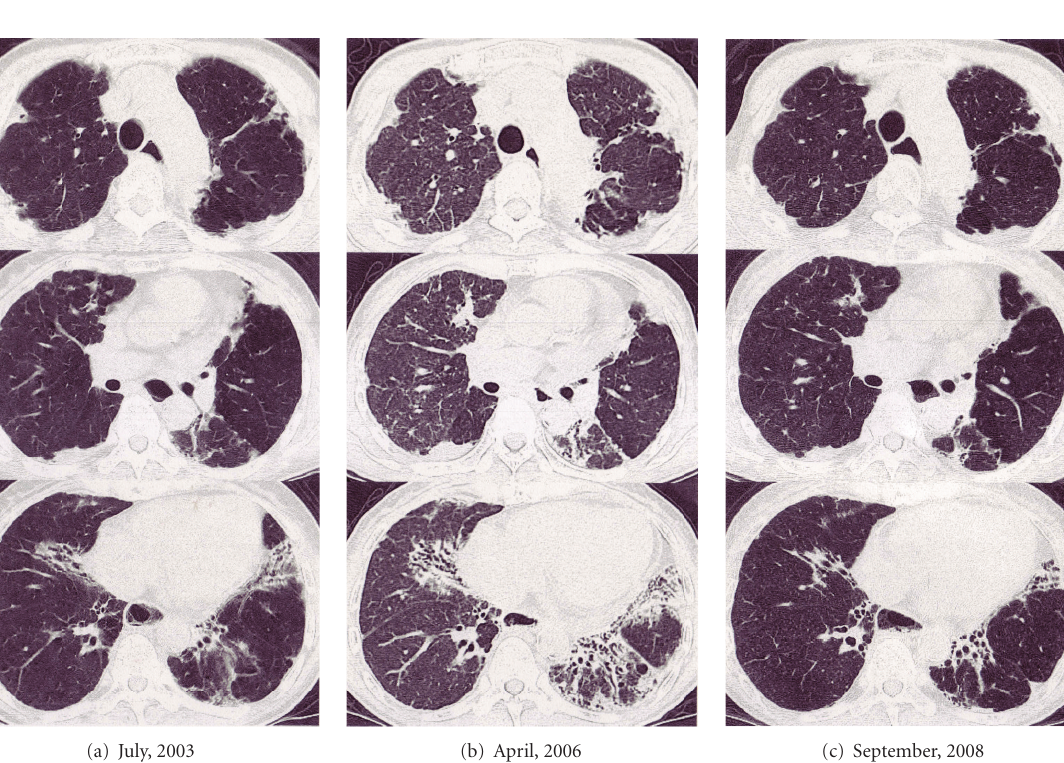
Figure 1: Clinical course. TLC: total lung capacity, VC: vital capacity, FVC: forced vital capacity, FEV1 / FVC: forced expiratory volume in 1s/forced vital capacity, DLCo: carbon monoxide di ff using capacity, and NT: not tested.